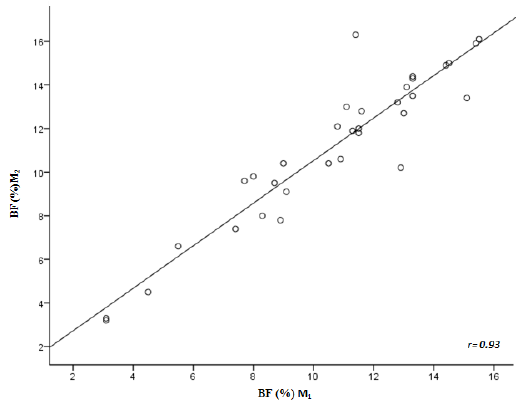
Figure 3. Correlation between the values of param- eters measured by Tanita before and after the intake of fluids – body fat (%)